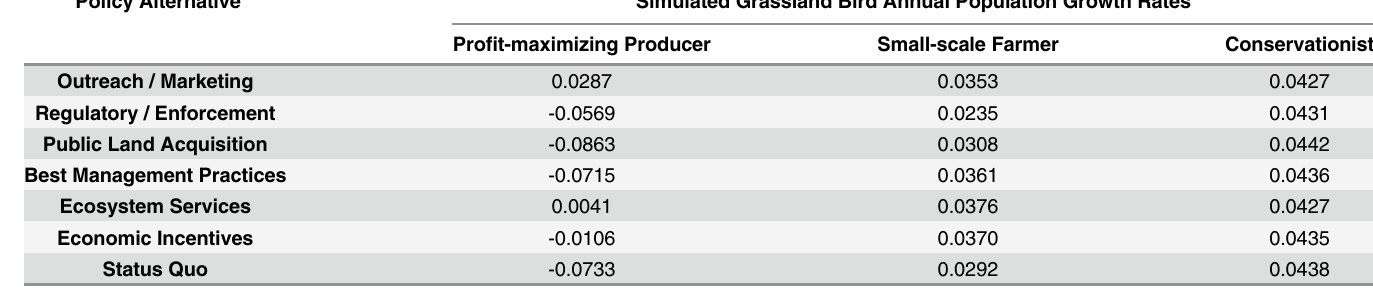
Table 2. The effect of each policy and landowner on the expected growth of grassland bird populations where alternatives and values were deter- mined by workshop participant expert opinion. Values indicate average population growth rates, per year, after a 30-year simulation period, in response to the respective policy alternatives, for each landowner